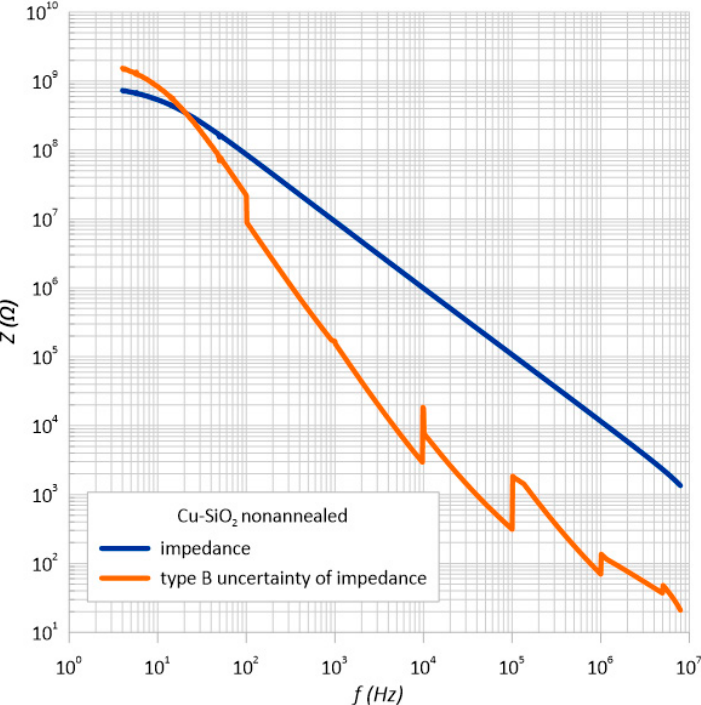
Figure 12. Frequency dependence of the impedance and standard impedance uncertainty of meas- urement type B u ( Z ) of the unheated structure.